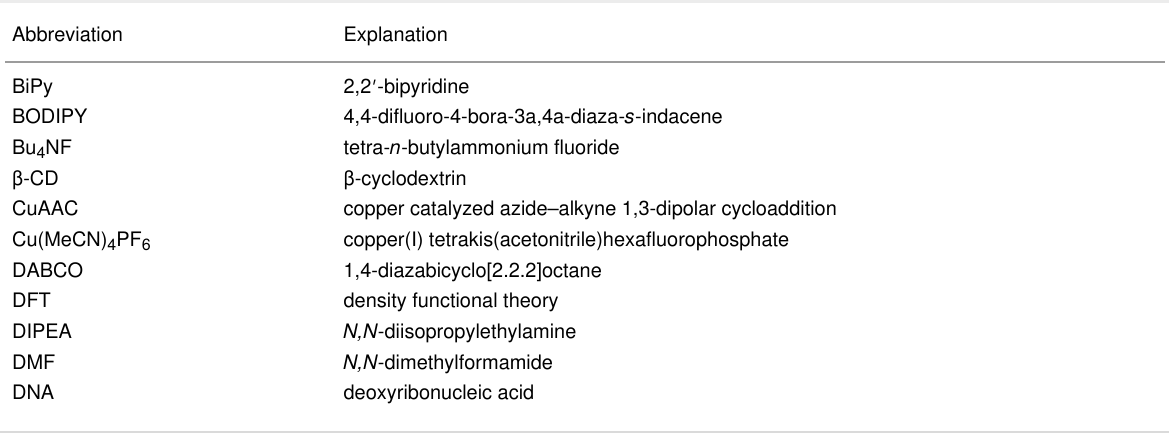
Table 1: Synonyms and abbreviations with their